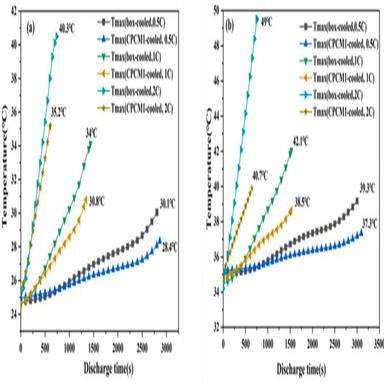
Temperature profiles of the battery cooled by different methods at various discharge rates under two ambient temperature: (a) 25 ◦C, (b) 35 ◦C.